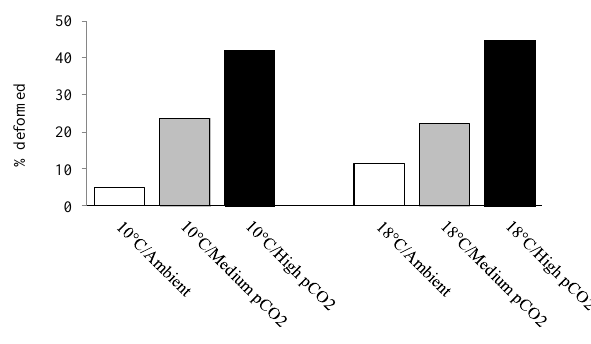
Fig. 7. Percentage of Homarus gammarus with deformities in the Figure 7. larval phase in the different temperature, 10 and 18 ◦ C, and p CO 2 treatments (ambient, medium and high).